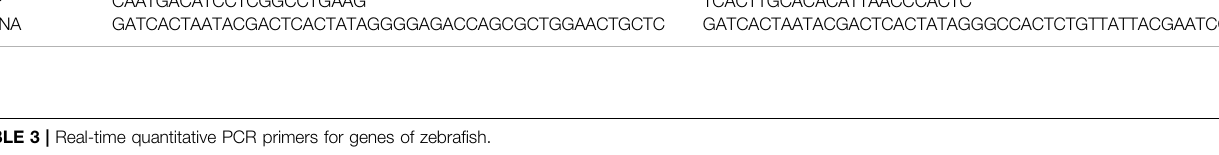
TABLE 3 | Real-time quantitative PCR primers for genes of zebra fi sh. Target